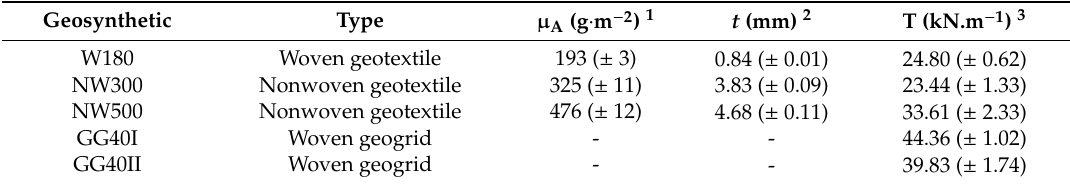
Table 1. Main properties of the